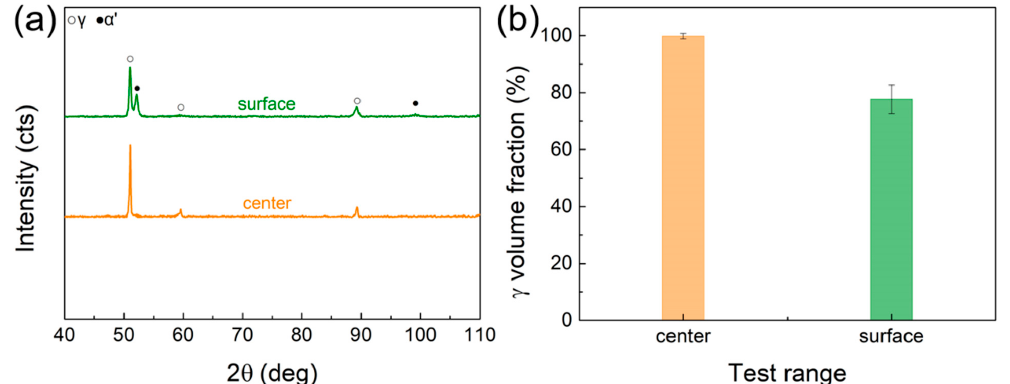
Figure 5. Phase composition of the core and side layers of HS sample. ( a ) XRD patterns for the center and surface layer; ( b ) austenite content in the center and surface layer.